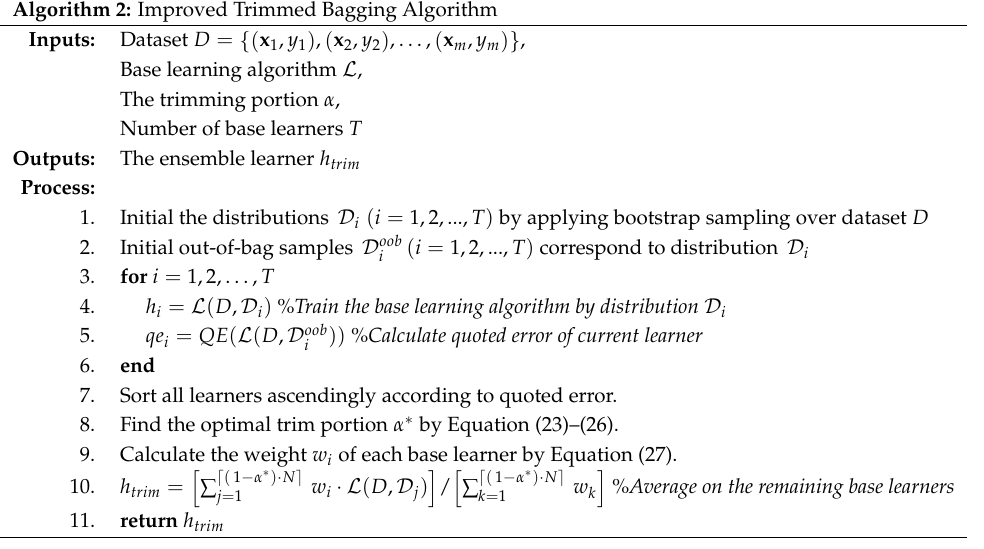
Algorithm 2: Improved Trimmed Bagging